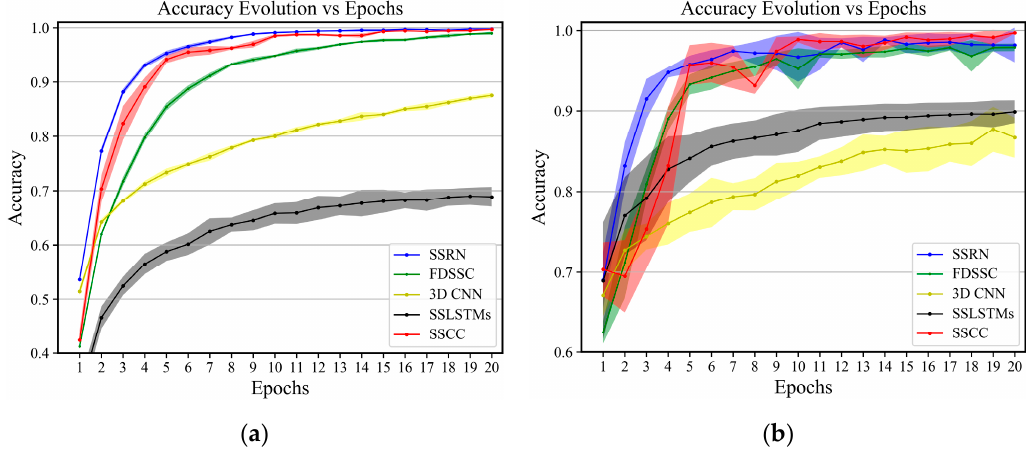
Figure 17. University of Pavia: Evolution of the accuracy in terms of epochs on ( a ) training data and ( b ) validation data. The shadow shows the standard deviation of the accuracy for five executions.